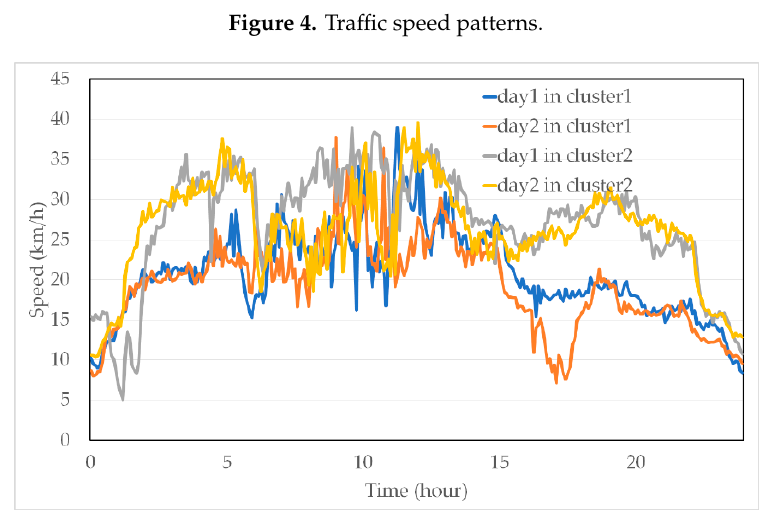
Figure 5. Distribution of traffic speed data in different clusters.